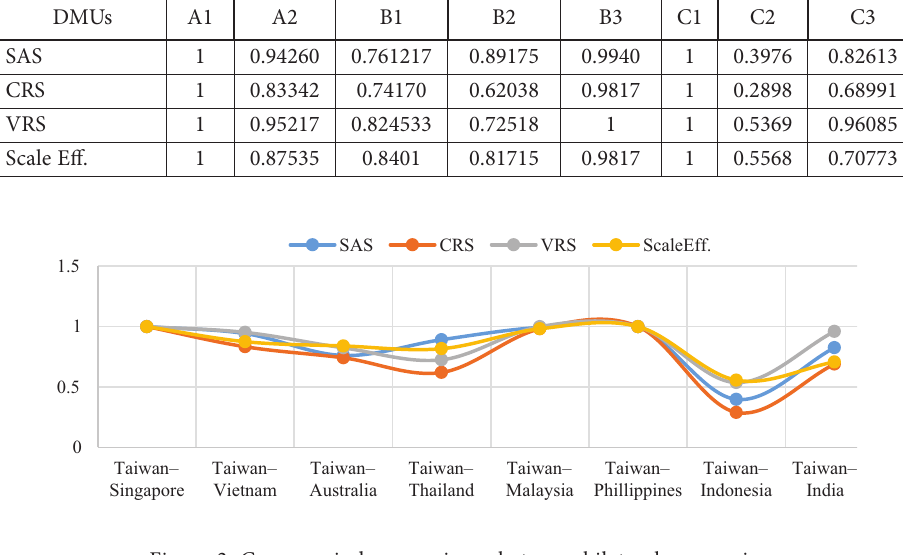
Figure 2. Cross-period comparisons between bilateral economies (source: compiled by the author) B1 followed in fourth by obtaining an average index of 0.84 in scale efficiency, with the SAS is placed between the CRS and VRS scores. The DMU outperformed in the years of 2015, 2016 and 2019 with all indices are scored at 1. However, B1 revealed to the non-convex structure in 2017 due to the smaller amount of an inward